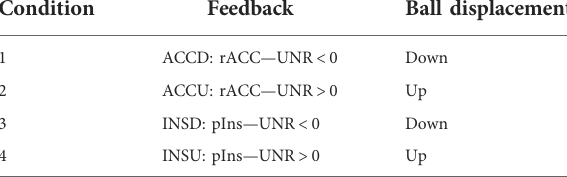
TABLE 2 The four conditions for the generation of the feedback signal and their association with the ball displacement on the visual